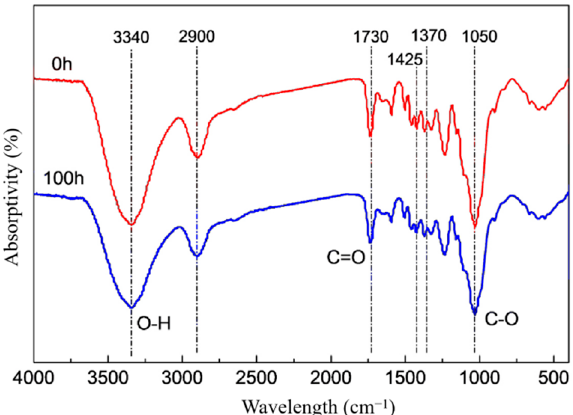
Figure 5. Chemical structure changes of dyed wood holocellulose before (the red line) and after (the blue line) UV radiation.